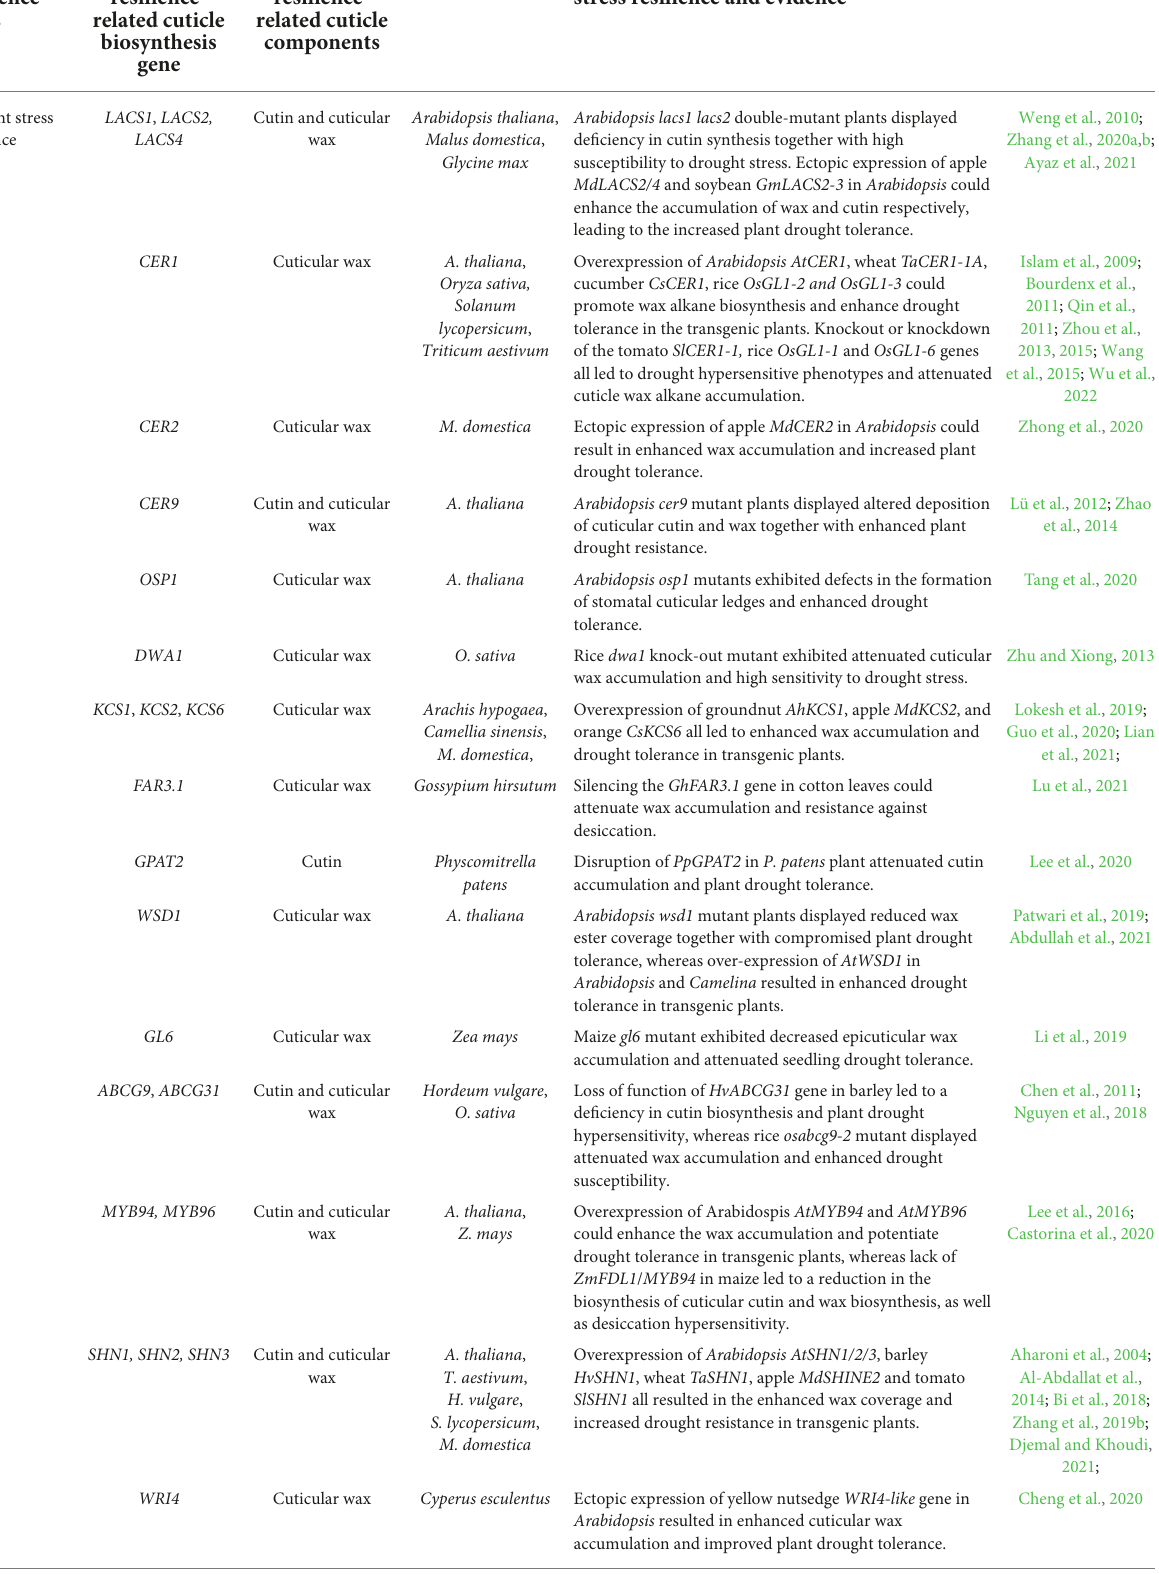
TABLE 1 Summary of plant resilience to drought, salinity, temperature, and ultraviolet (UV) stress contributed by cuticle